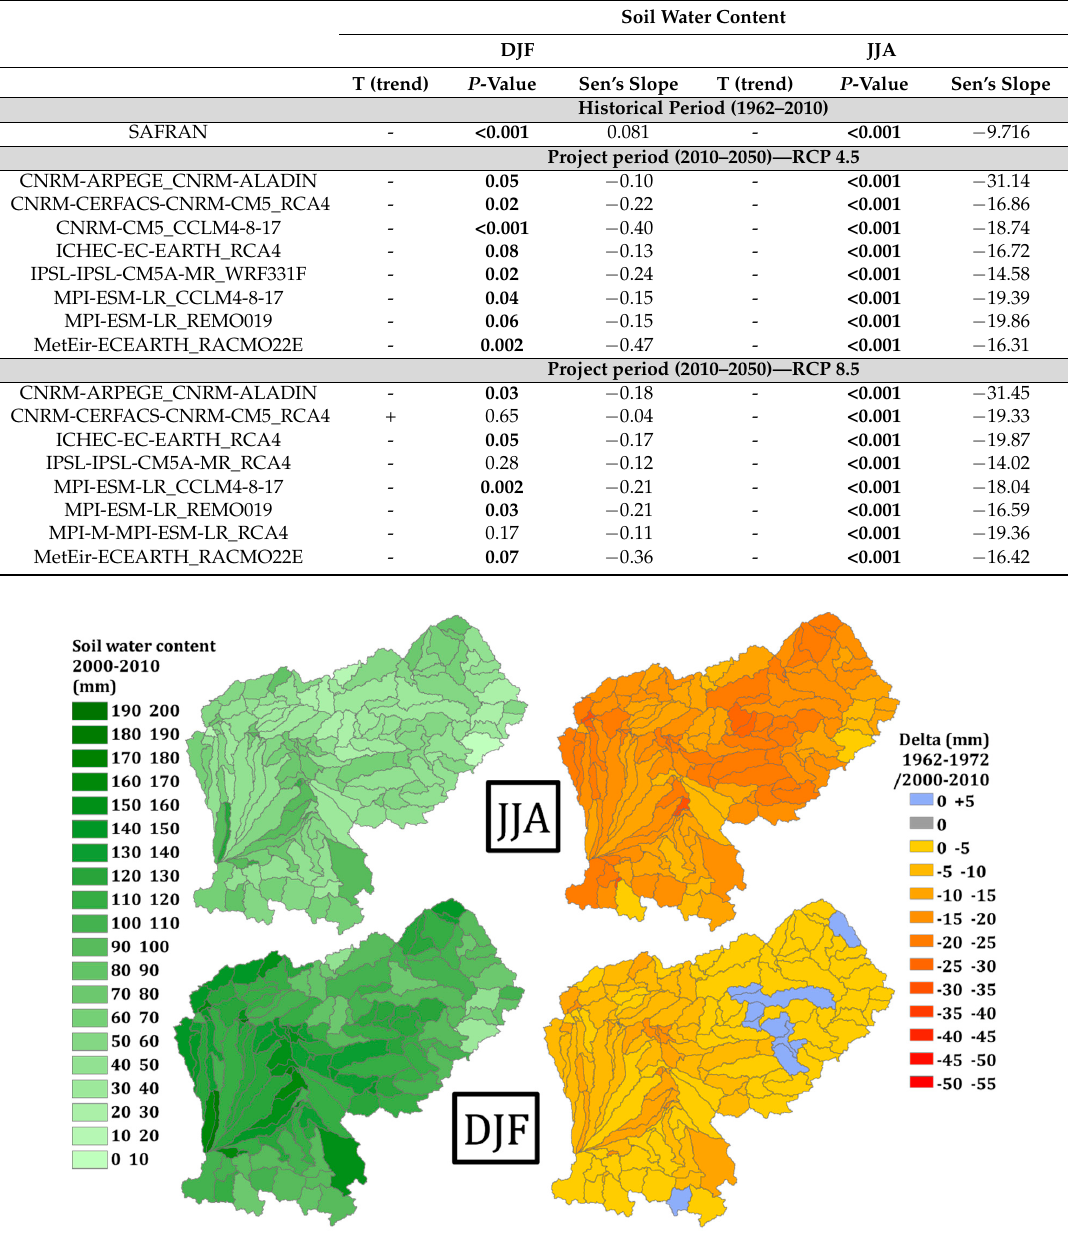
Figure 11. Soil water content during the 2000–2010 decade and variations with the 1962–1972 decade.